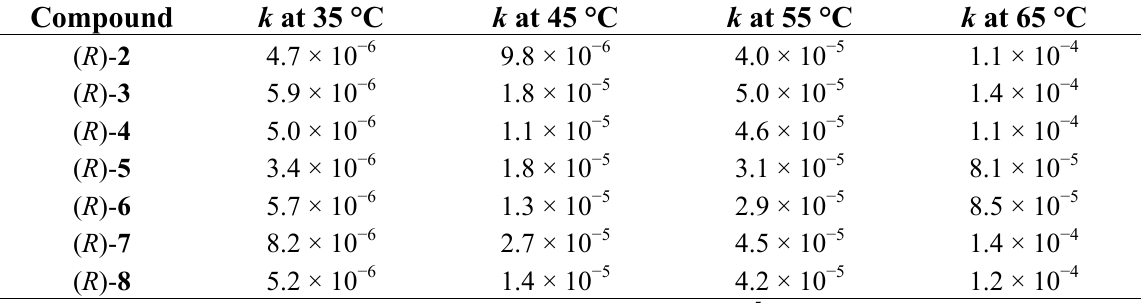
Table 2. Rate constants k (s − 1 ) of cis to trans isomerization of ( R )- 2 - 8 . Compound